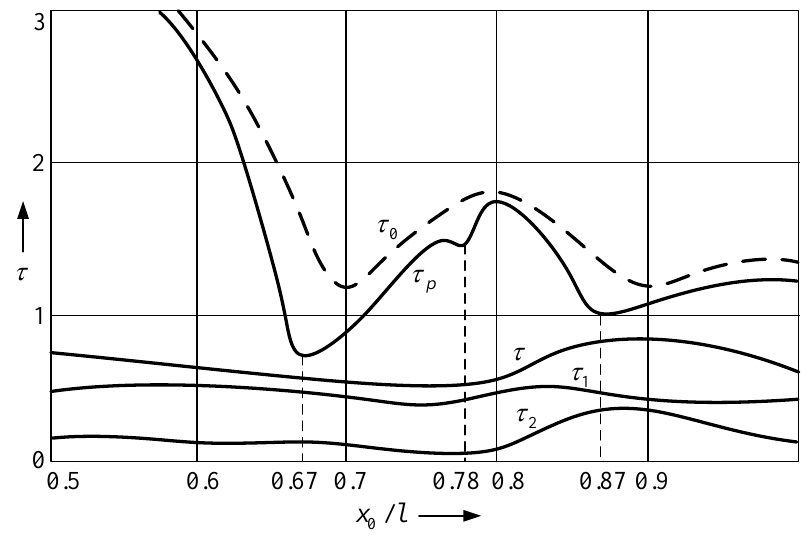
=  T (for m = 50),  p 1 p